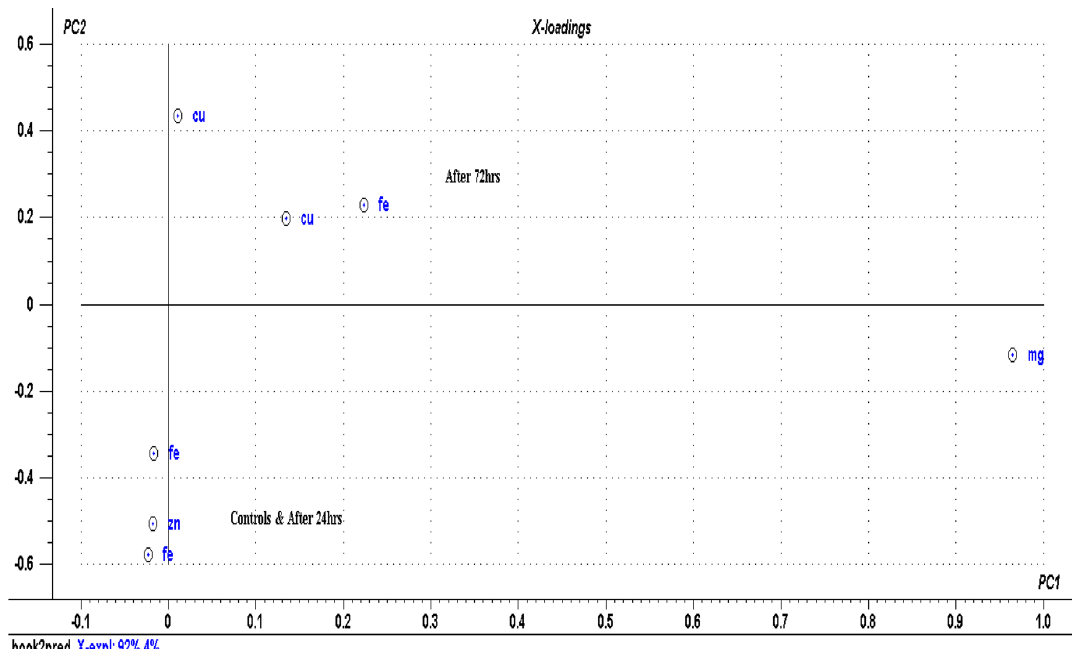
Figure 7. PCA loadings plot for cultured blood samples based on predicted biometal